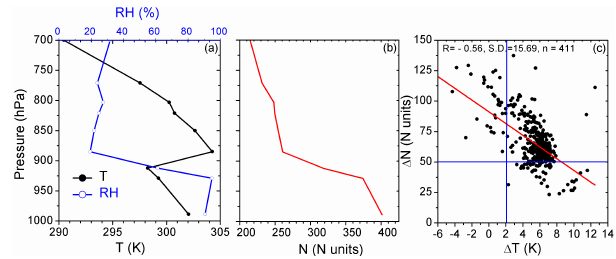
Figure 9. Typical examples showing MI in temperature and RH on (a) 27 June 1979 at 06:56GMT at 20 ◦ N, 62 ◦ E obtained from dropsondes from MONEX experiment, (b) N profile, (c) scatter plot of (cid:49)T and (cid:49)N .